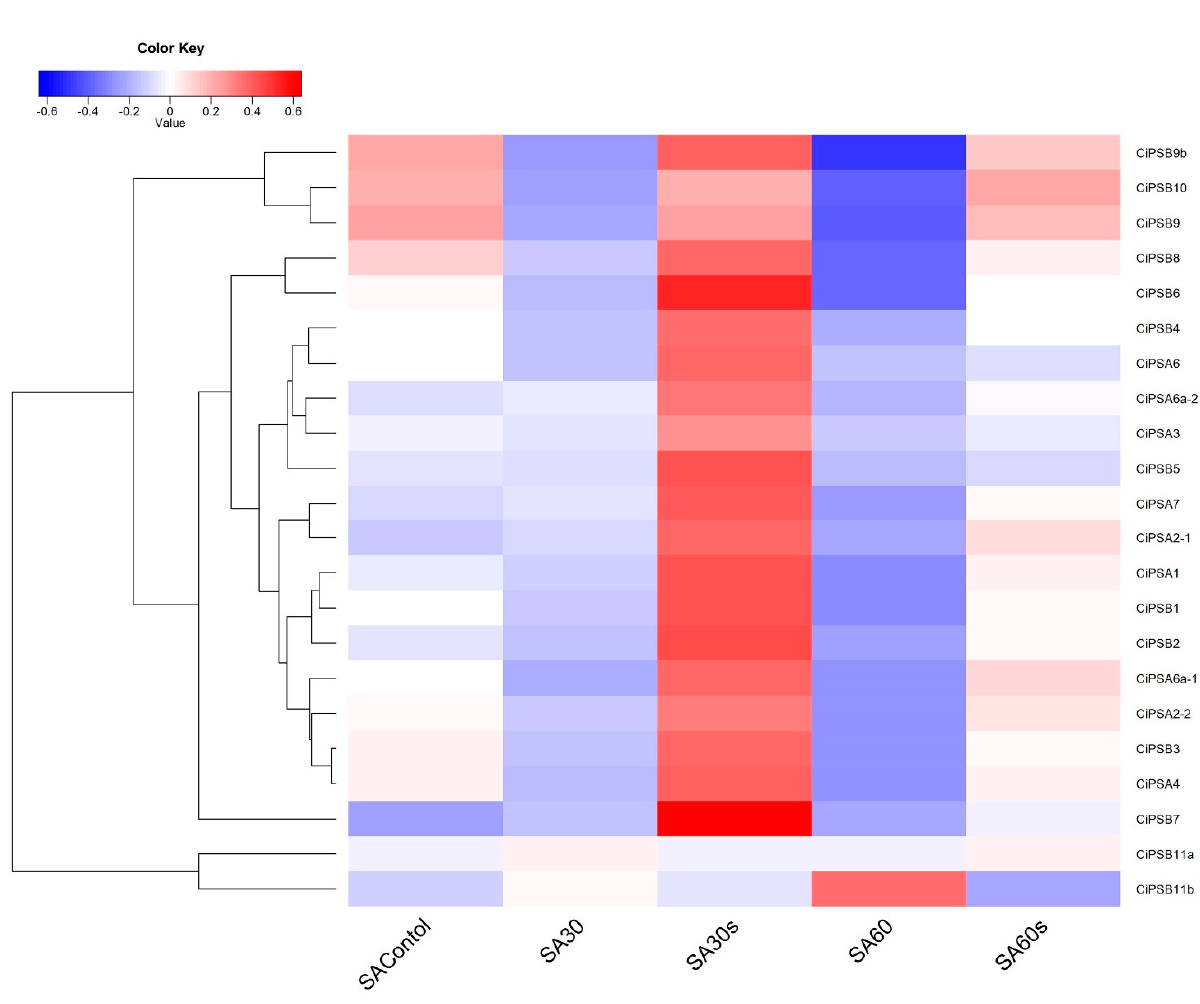
Figure 8. Expression profile of CiPS gene family members response to high saline-alkali stress in grass carp. Note: SAcontrol means gill samples of grass carp were collected from 0 saline-alkali groups; SA30 means gill samples of grass carp were collected from 3‰ saline-alkali groups, and grass carp was not injured); SA30s means gill samples of grass carp were collected from 3‰ saline-alkali groups, and grass carp was injured); SA60 means gill samples of grass carp were collected from 6‰ saline-alkali groups, and grass carp was not injured); SA60s means gill samples of grass carp were collected from 6‰ saline-alkali groups, and grass carp was injured.